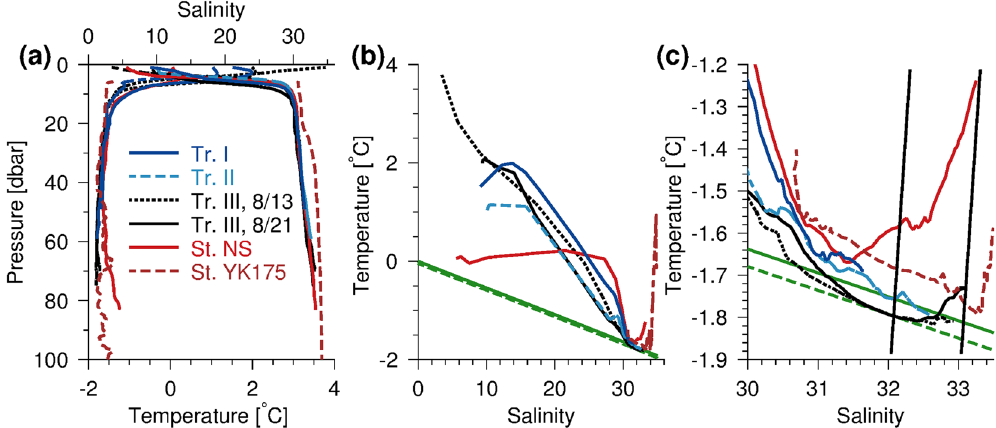
Figure 4. TS-diagrams. ( a ) Temperature and salinity profiles near terminus at transect I (blue), transect II (dashed lightblue), transect III (black dashed (13 Aug.) and solid (21 Aug.) lines), station NS (red line) and on the shelf (YK175, brown dashed line). ( b ) TS-diagram and ( c ) for S > 30. Meltlines (black near-vertical lines) and lines of freezing temperature are shown for P = 0 dbar (green) and P = 55 dbar (dashed green), respectively.